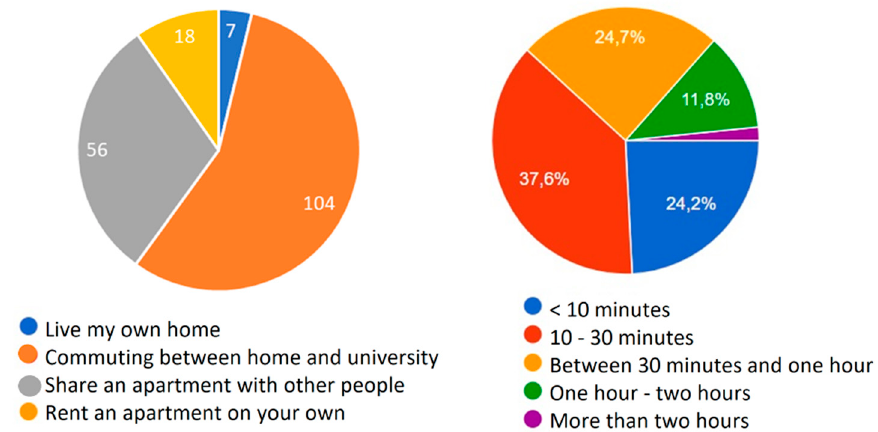
Figure 3. Place of residence during the investigation (left) and time to travel to reach the university from place of residence (right).